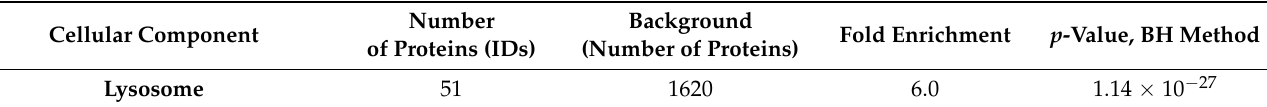
Table 2. Analysis of cell component distribution of the proteins identified as palmitoylated in bovine follicular cells, using FunRich software